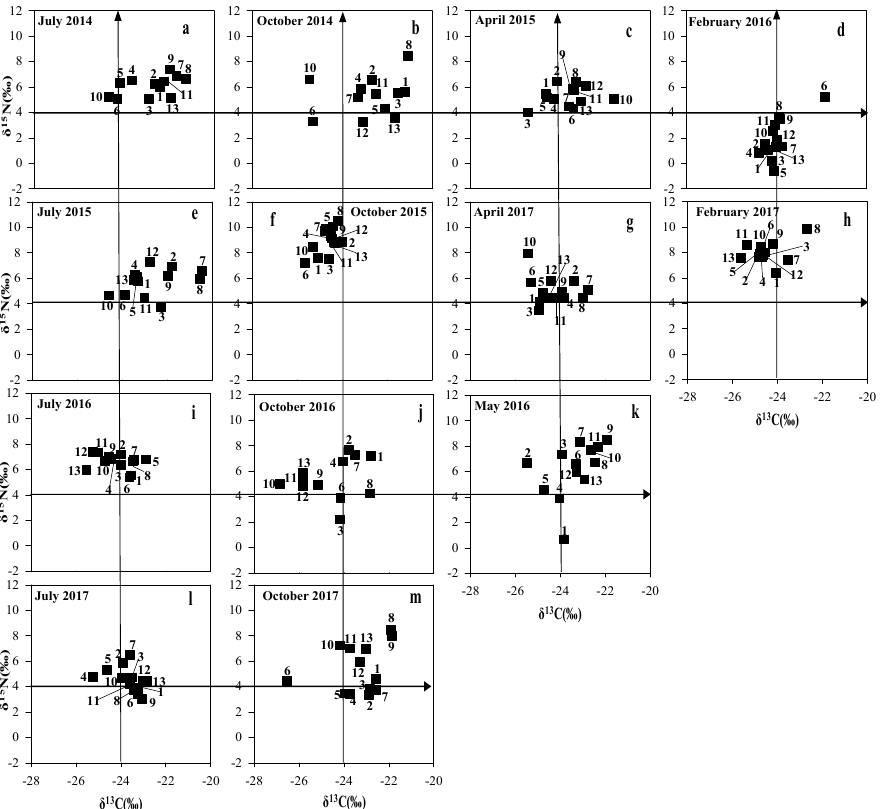
Figure 7. Biplots of δ 13 C and δ 15 N values of SPOM in Maryland Coastal Bays (July 2014–October 2017). 1–13 indicate sampling sites. The number of sites with δ 13 C values < − 24 varied